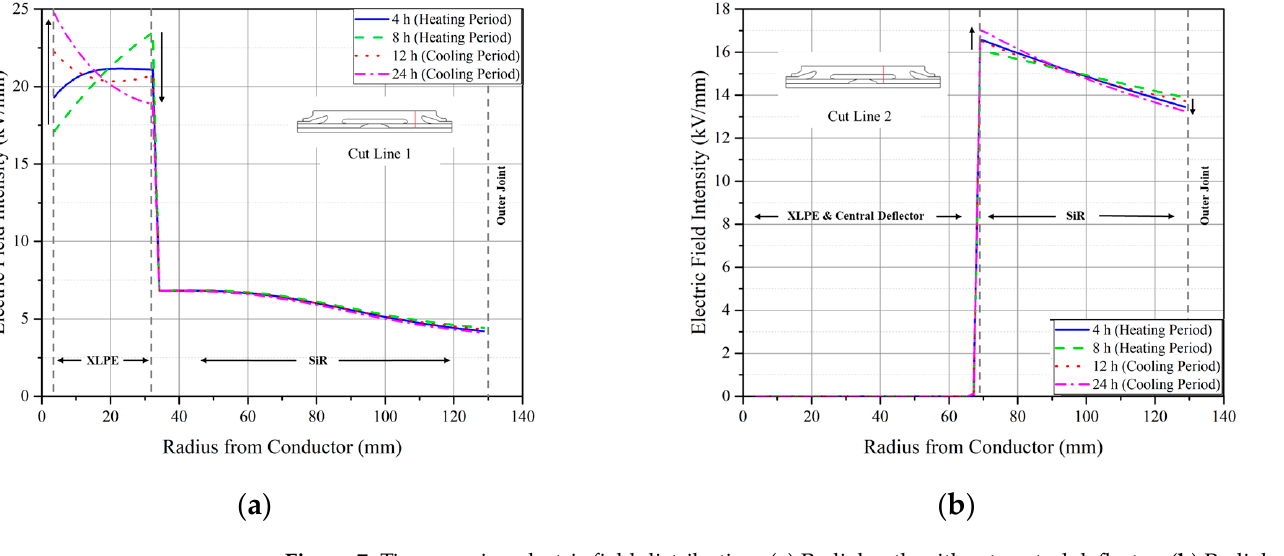
Figure 7. Time-varying electric field distribution: ( a ) Radial path without central deflector; ( b ) Radial path with central deflector.